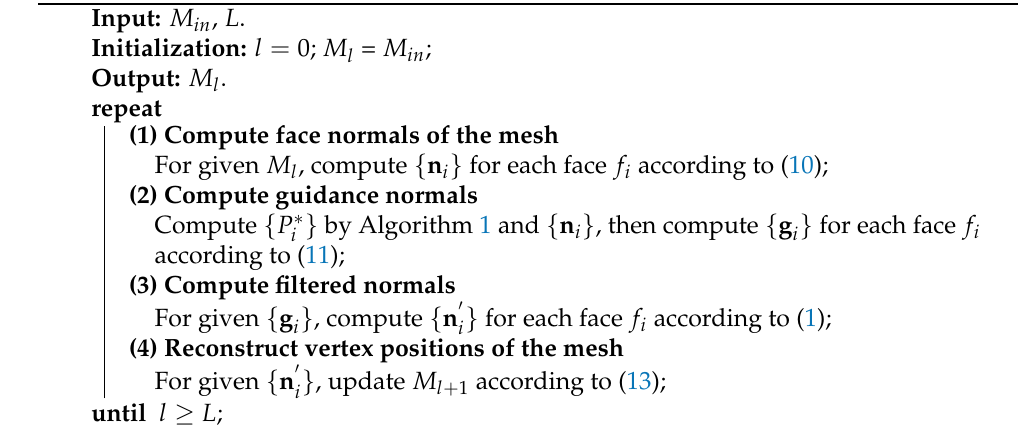
Algorithm 2: Our mesh normal filtering